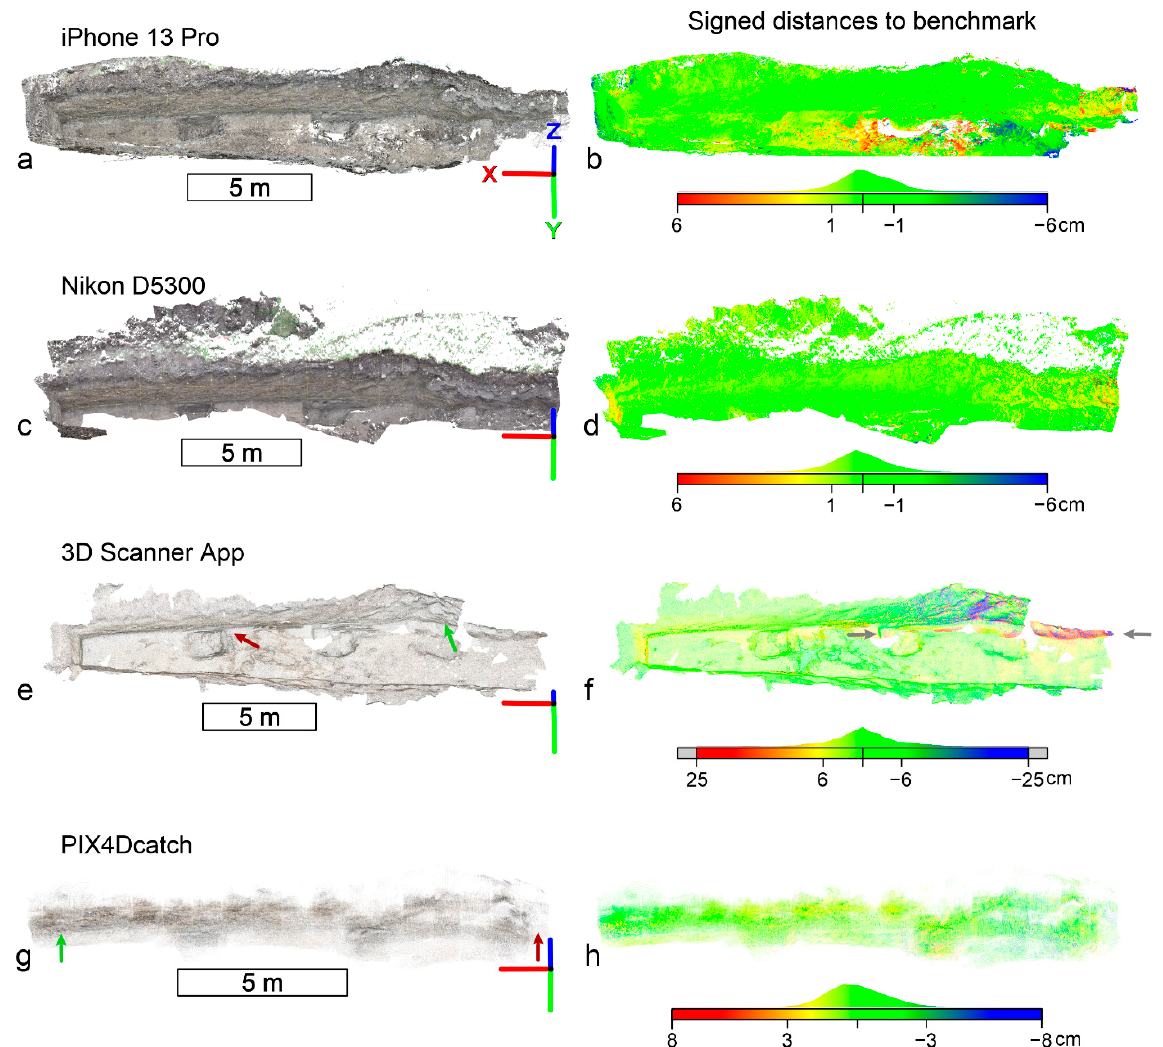
Figure 4. The iPhone (photogrammetric) RGB colored point cloud ( a ) and its distance to the benchmark model ( b ). The Nikon RGB colored point cloud ( c ) and its distance to the benchmark model ( d ). The 3D Scanner App colored point cloud ( e ) and its distance to the benchmark model ( f ). The PIX4Dcatch app RGB colored point cloud ( g ) and its distance to the benchmark model ( h ). Green and red arrows in e and g represent the first and last view of the acquisition. Gray arrows in f represent artifact points related to self ‐ localization and mapping (SLAM) errors. The Red Green and Blue Cartesian system represent the East, North and Up directions, respectively.